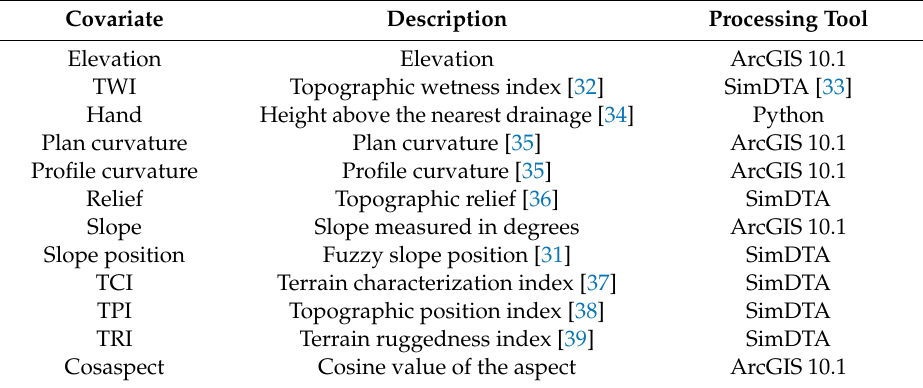
Table 1. Description of environmental